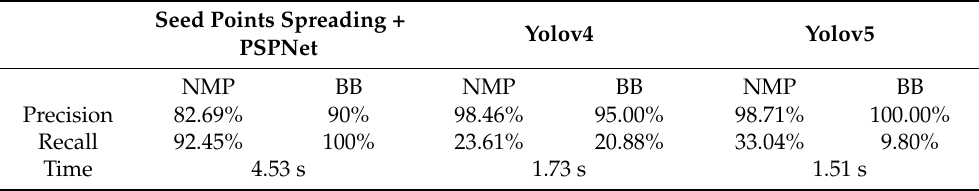
Table 6. The precision and recall of each group of comparative